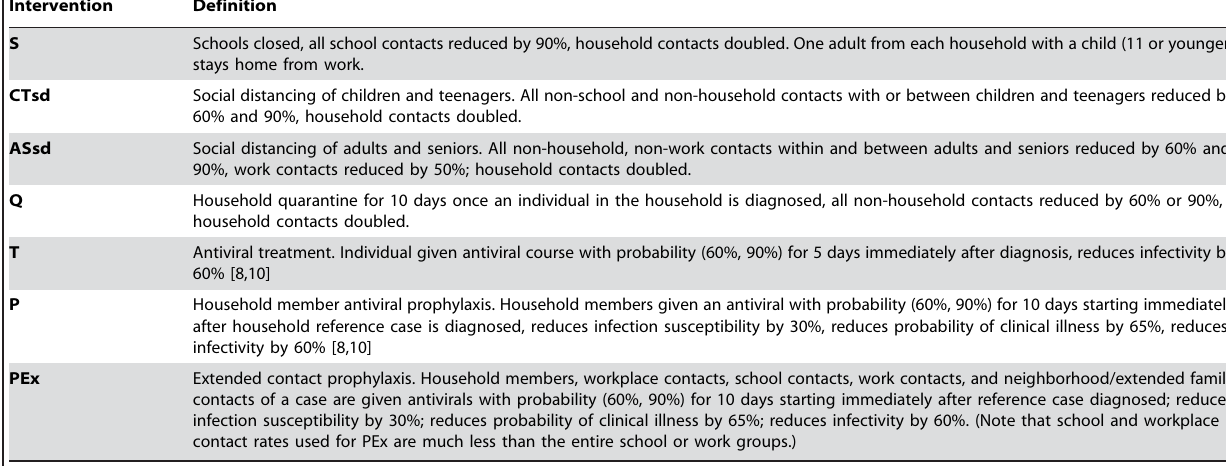
Table 1. Mitigation Interventions.